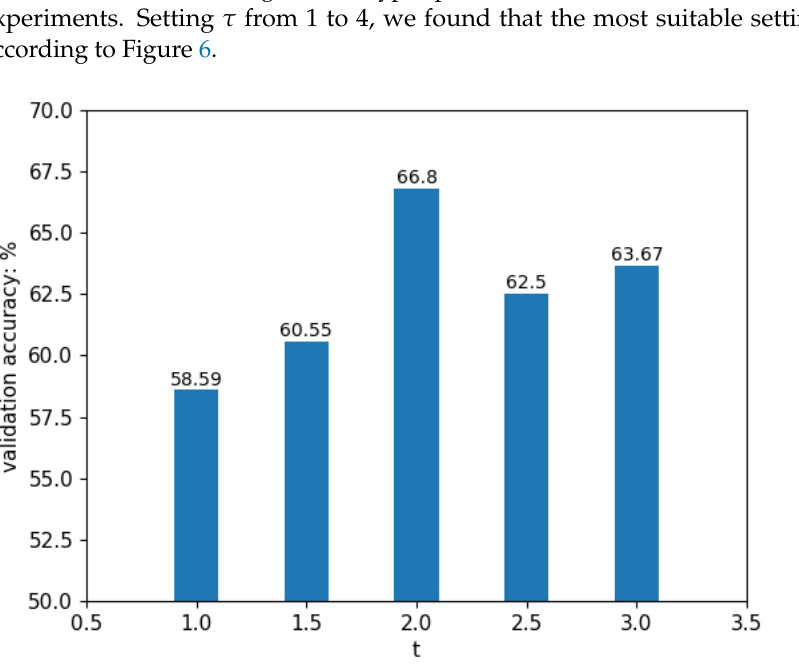
Figure 6. Experiments on different settings of the hyper-parameter τ .